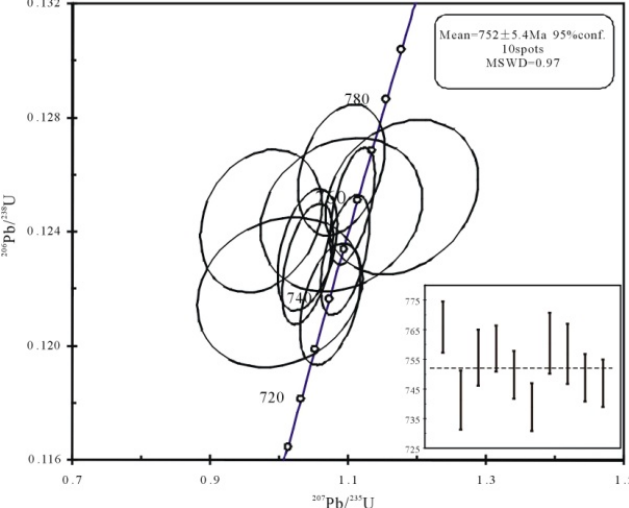
Figure 4. U–Pb concordia diagram of zircons from the Xingdi No.2 gabbro (D2-1-10).